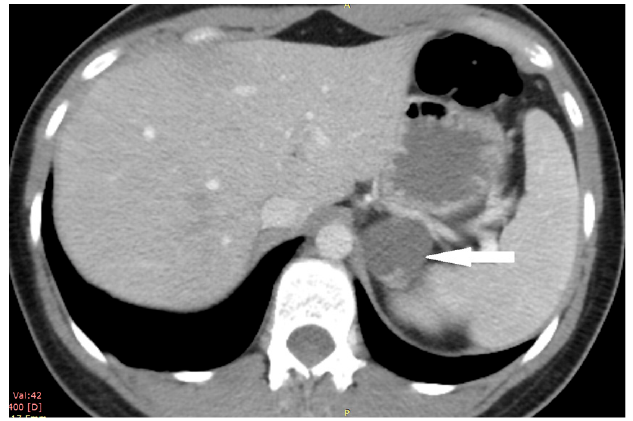
Figure 8. Adrenal lymphangioma. Abdomen CT, transverse cross-section, after eight years.